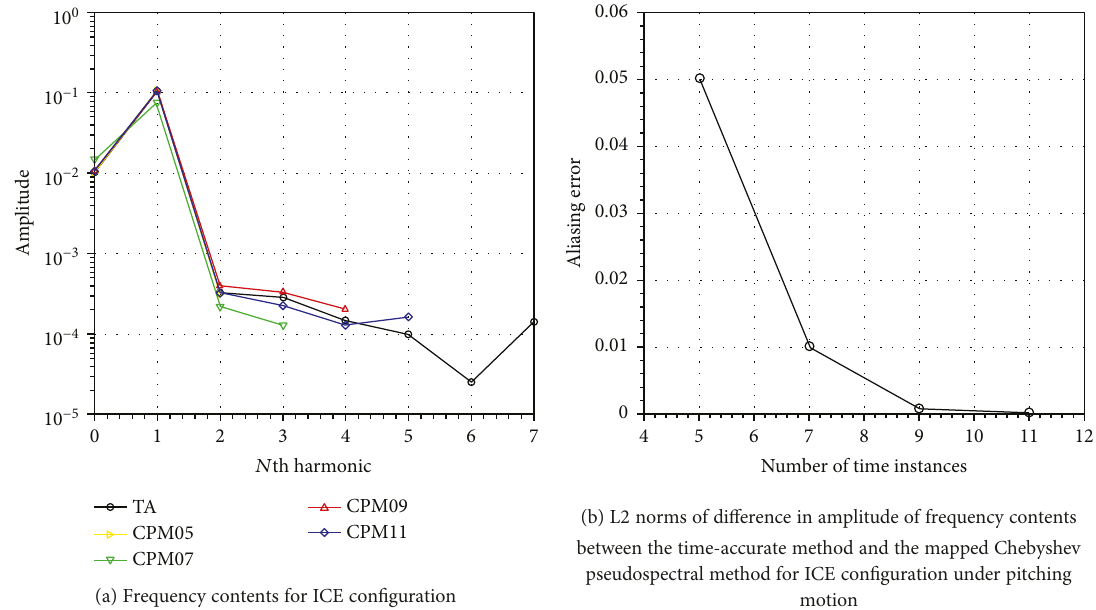
Figure 6: Frequency analysis for the time-accurate method and the time-spectral method results.